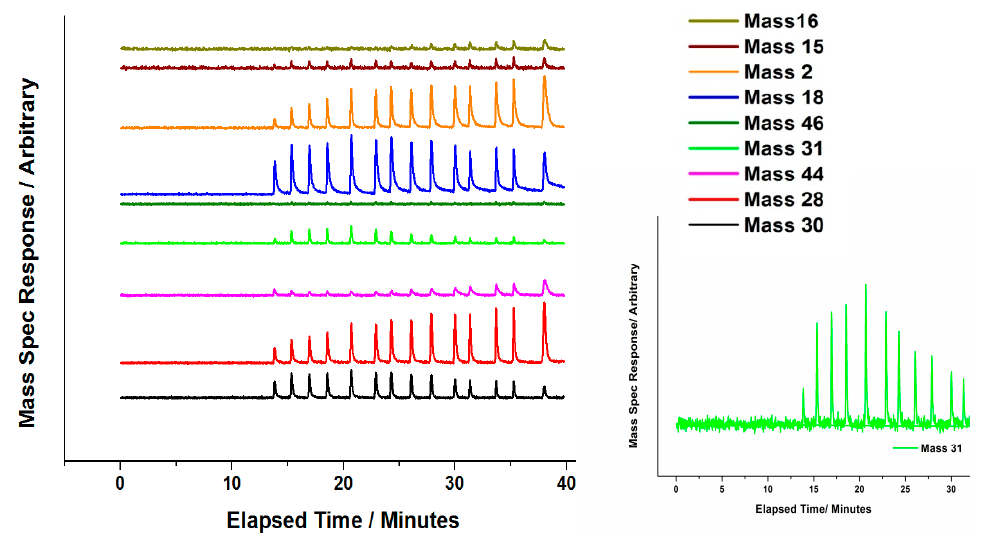
Figure 26. Pulsed flow data for MoO 3 under anaerobic conditions at 350 °C, experimental as Figure 25.